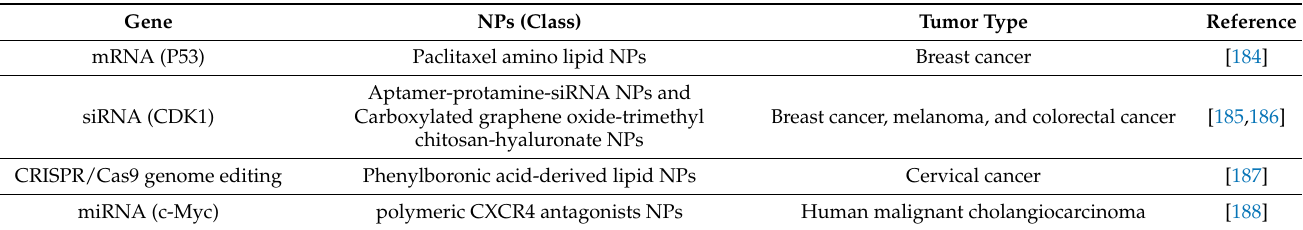
Table 2. List of polymer NPs in gene therapy for cancer